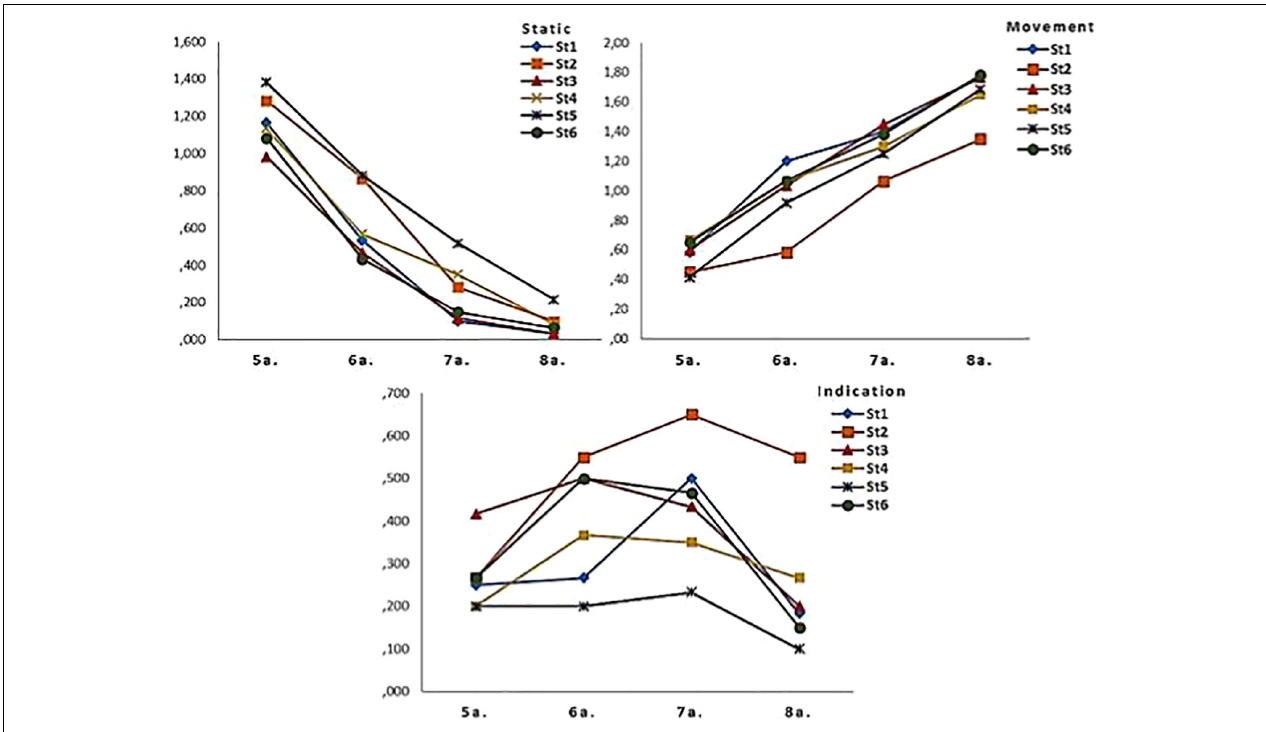
FIGURE 1 | Representation of macrocategories according to